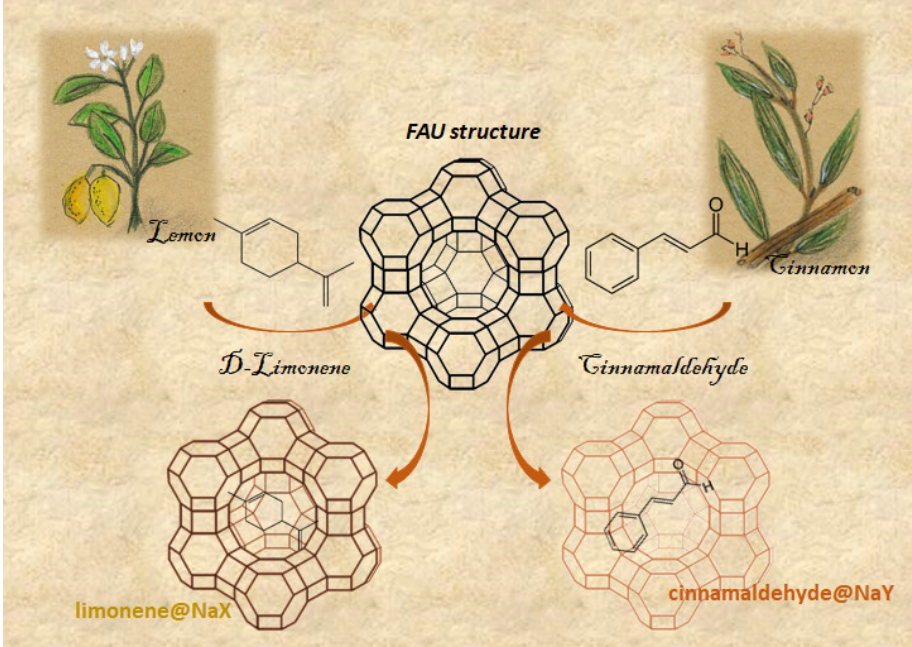
Figure 6. General scheme of the encapsulation of the EO compounds D-limonene and cinnamalde- hyde in NaX and NaY faujasite zeolite structures, respectively (adapted from [106]).